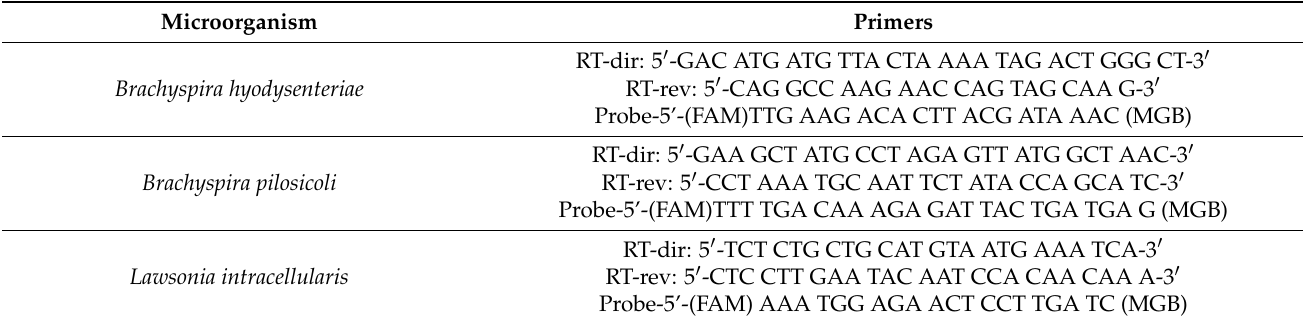
Table 1. Primers and probes used for